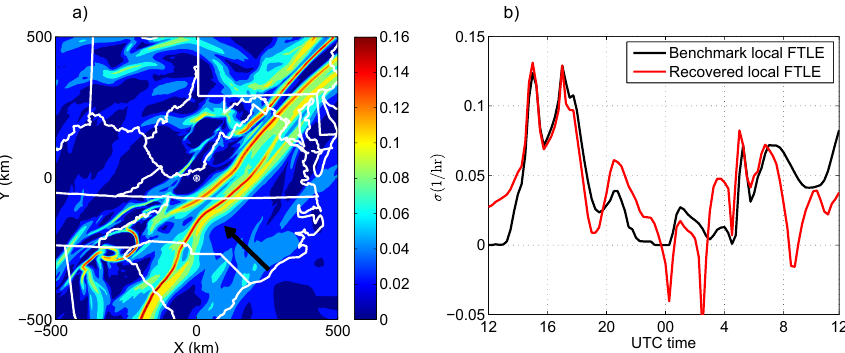
Figure 9. (a) The frozen image corresponding to 12:00UCT 29 September 2010 of the backward FTLE field during the interrogation window. Integration time is 24h for FTLE calculations. The bold arrow shows the general wind direction and the motion of the attracting LCS. (b) The true (black) and recovered (red) local FTLE time series at the reference point (0, 0). For the recovered time series (red), δt is equal to 0.1h.